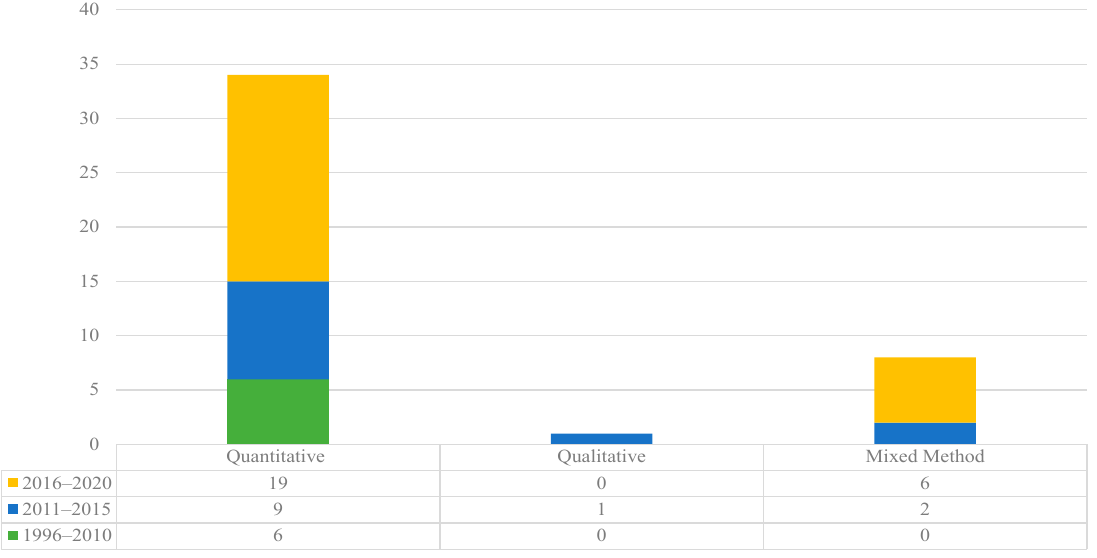
Figure 10. Research methods of AIME research in each period.